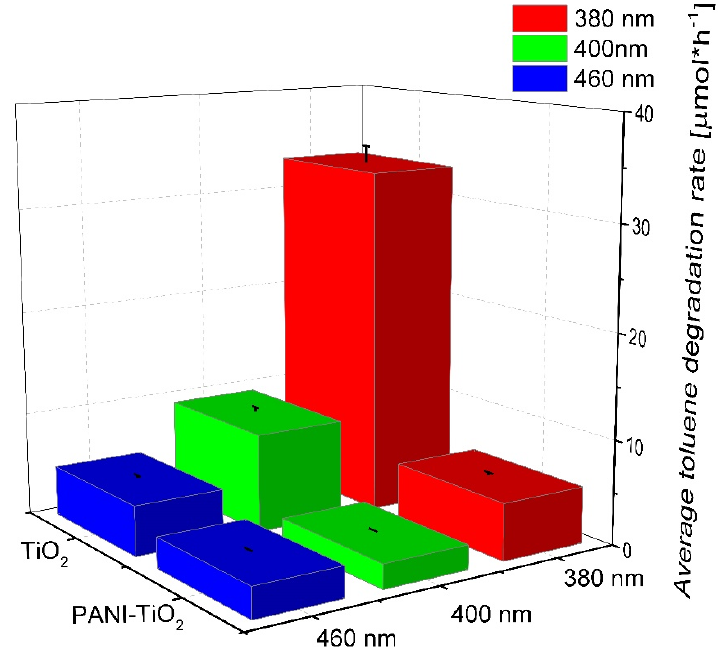
Figure 9. Photocatalytic activity of pure TiO 2 and the PANI–TiO 2 nanocomposite in the gas phase. Irradiation time: 3 h, toluene initial concentration: 200 ppm, photocatalyst loading: 15 mg .